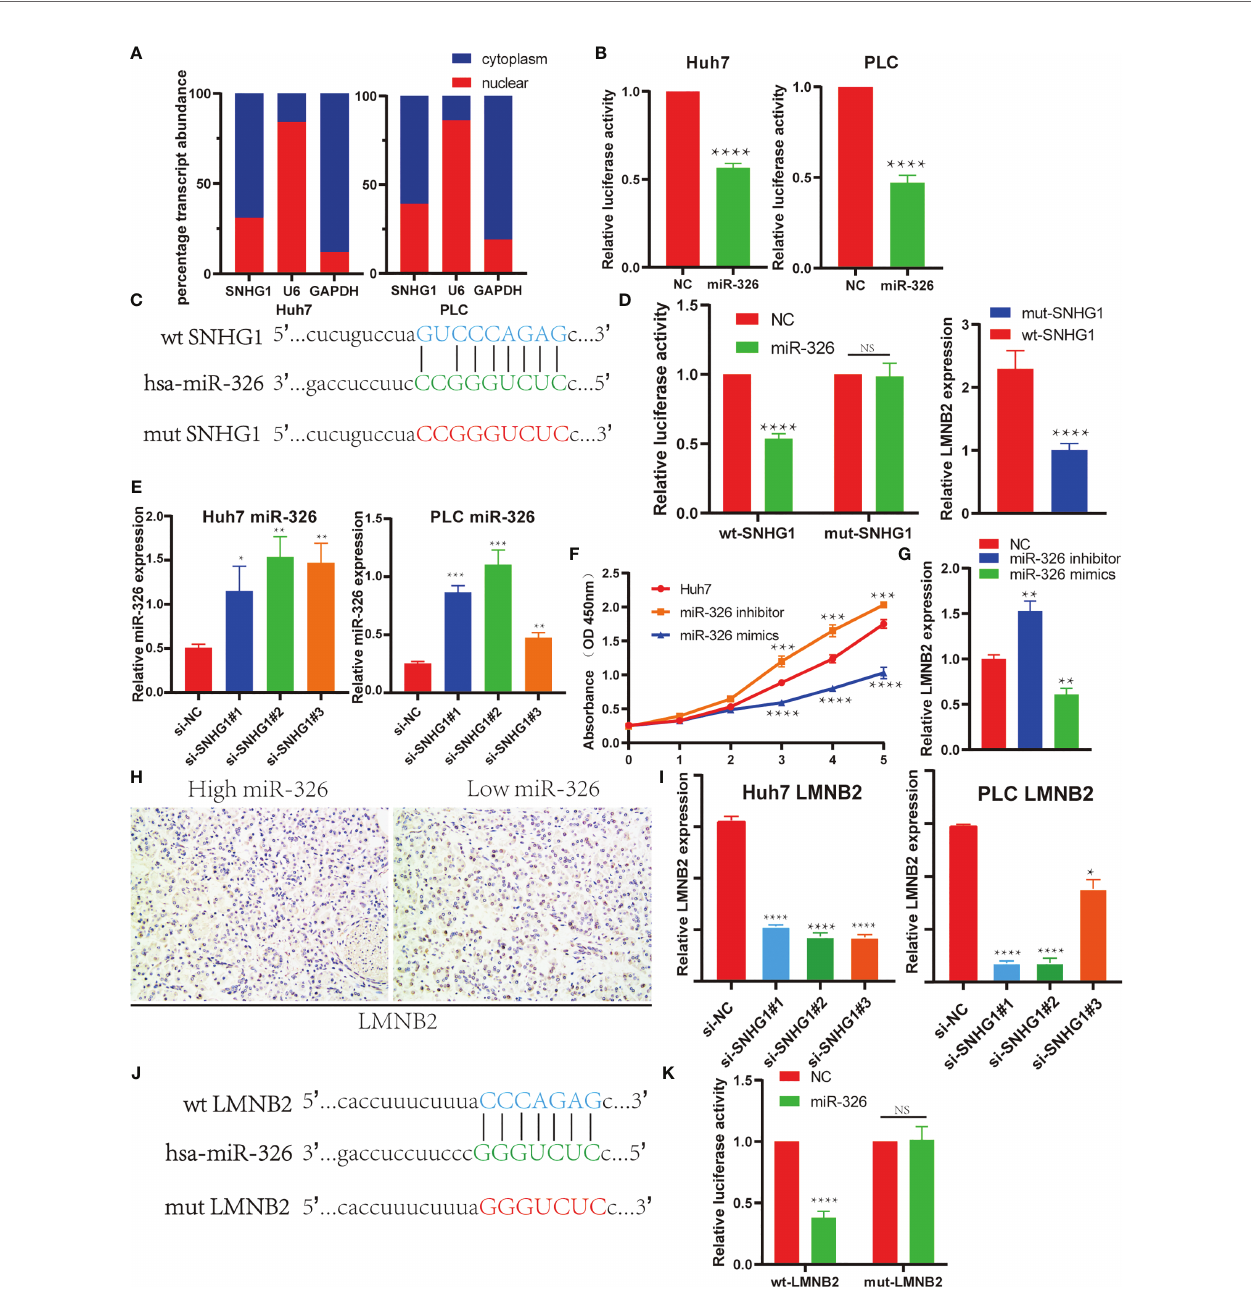
FIGURE 7 | SNHG1 regulated LMNB2 expression through sponging miR-326 in hepatocellular carcinoma (HCC) cells. (A) Subcellular localization of SNHG1 was detected by quantifying nuclear and cytoplasmic fractions. U6 and glyceraldehyde 3-phosphate dehydrogenase (GAPDH) were used as nuclear and cytosolic controls, respectively. (B) Dual-luciferase reporter assay showed that miR-326 directly interacted with SNHG1 in Huh7 and PLC cells (****p < 0.0001). (C) The potential binding site of SNHG1 and miR-326 predicted by StarBase. The sequence alignment of miR-326 and the predicted binding region in SNHG1 (green). Predicted miR-326 binding sites (blue) in SNHG1 and position of mutated nucleotides in SNHG1 (red). (D) Dual-luciferase reporter assay was performed to detect the binding of miR- 326 with WT- SNHG1 in Huh7 cells. Expression of LMNB2 in Huh7 cells after addition of wt- SNHG1 compared with mut- SNHG1 (****p < 0.0001). (E) Expression of miR-326 in Huh7 and PLC cells with SNHG1 knockdown (*p < 0.05, **p < 0.01, ***p < 0.001). (F) OD value of Huh7 cells in the MTT assay demonstrated that miR- 326 mimics could inhibit cell proliferation signi fi cantly, while miR-326 inhibitor could accelerate HuH7 cell proliferation (***p < 0.001, ****p < 0.0001). (G) Expression of LMNB2 in Huh7 cells transfected with miR-326 mimics and inhibitor was measured by qRT-PCR (**p < 0.01). (H) Representative immunohistochemistry (IHC) images of LMNB2 are shown in hepatocellular carcinoma with different miR-326 expression levels. (I) RNA levels of LMNB2 in Huh7 and PLC cells with SNHG1 knockdown detected by RT-qPCR (*p < 0.05, ****p < 0.0001). (J) The potential binding site of LMNB2 and miR-326 predicted by StarBase. The sequence alignment of miR-326 and the predicted binding region in LMNB2 (green). Predicted miR-326 binding sites (blue) in LMNB2 and position of mutated nucleotides in SNHG1 (red). (K) Dual-luciferase reporter assay was performed to detect the binding of miR-326 with wt- LMNB2 in Huh7 cells (****p < 0.0001). NS, No Signi fi